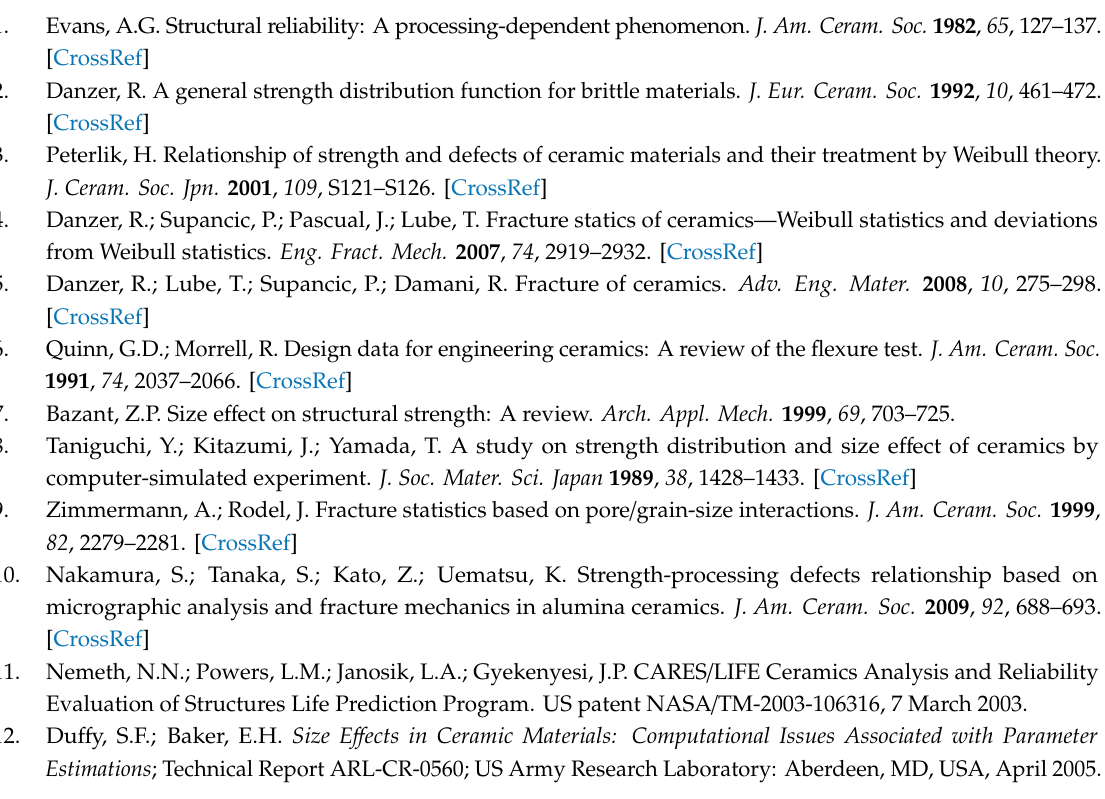
Figure A2. Numerically-obtained Weibull distributions by using Equation (A1). For each test, N = 30 specimens were used. The dashed line is the experimentally-obtained result of the Al 2 O 3 /30 vol% SiC particle composite ( m = 14.5 and β = 1055 MPa) [16].